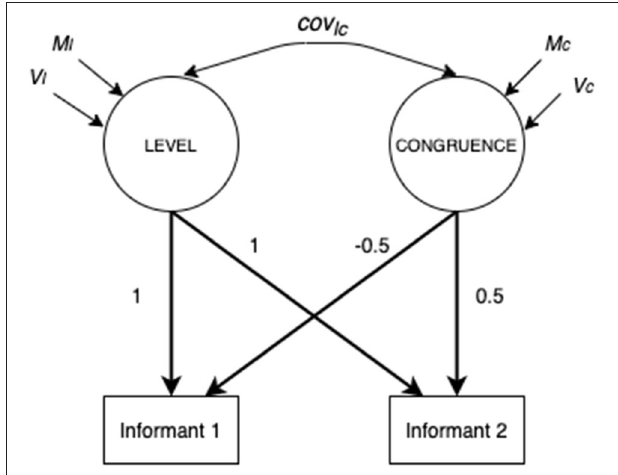
FIGURE 1 | Simplest LCM on observed variables (Figure adapted from Cheung, 2009, p.